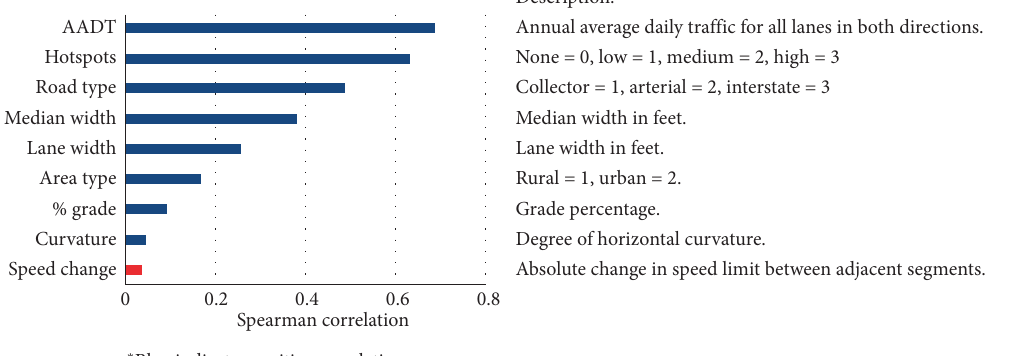
Figure 3: Crash rate feature